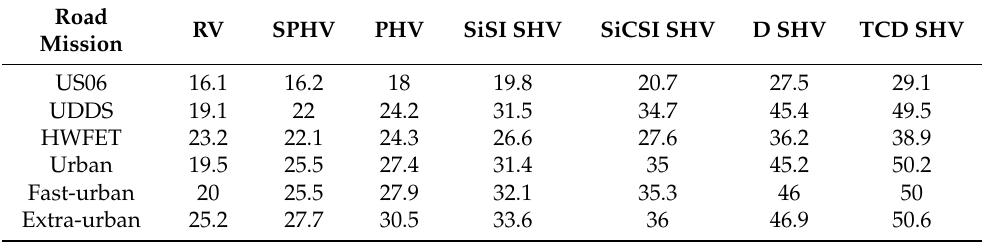
Table 15. Comparison among the fuel economy of different HEVs for different road missions (km/l).